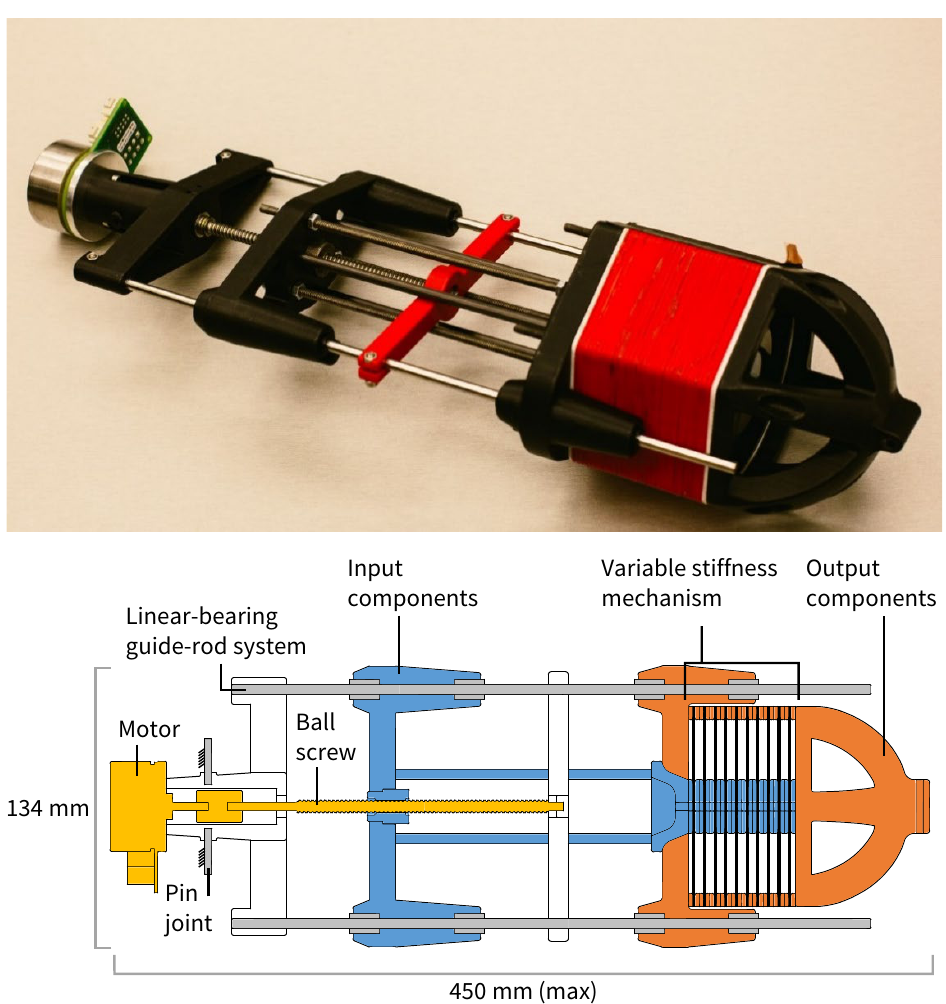
Figure 3. Our DET variable-stiffness actuator (VSA). This actuator has only one component motion in its variable-stiffness mechanism: the relative translation of the DET modules’ center disks and outer frames. The modules’ center disks are connected to the input components (blue), which are driven by the VSA’s motor and ball screw (yellow). The modules’ outer frames are connected to the actuator’s load by the output components (orange). Both the input and output components are constrained to linear motion by the linear-bearing guide-rod system. The variable-stiffness mechanism consists of 32 DET modules (30 active, and two insulating) though the diagram shows only ten for clarity. The variable-stiffness mechanism softens when the DET modules are charged with constant